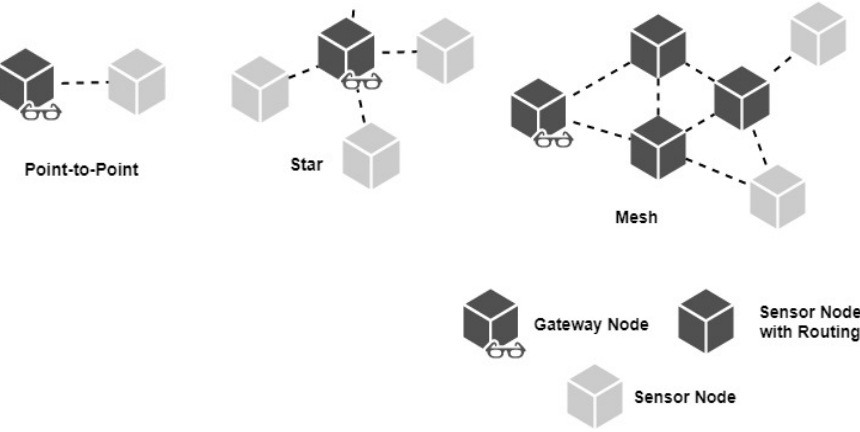
Figure 1. Network topologies commonly used by the Internet of Things (IoT) [4].